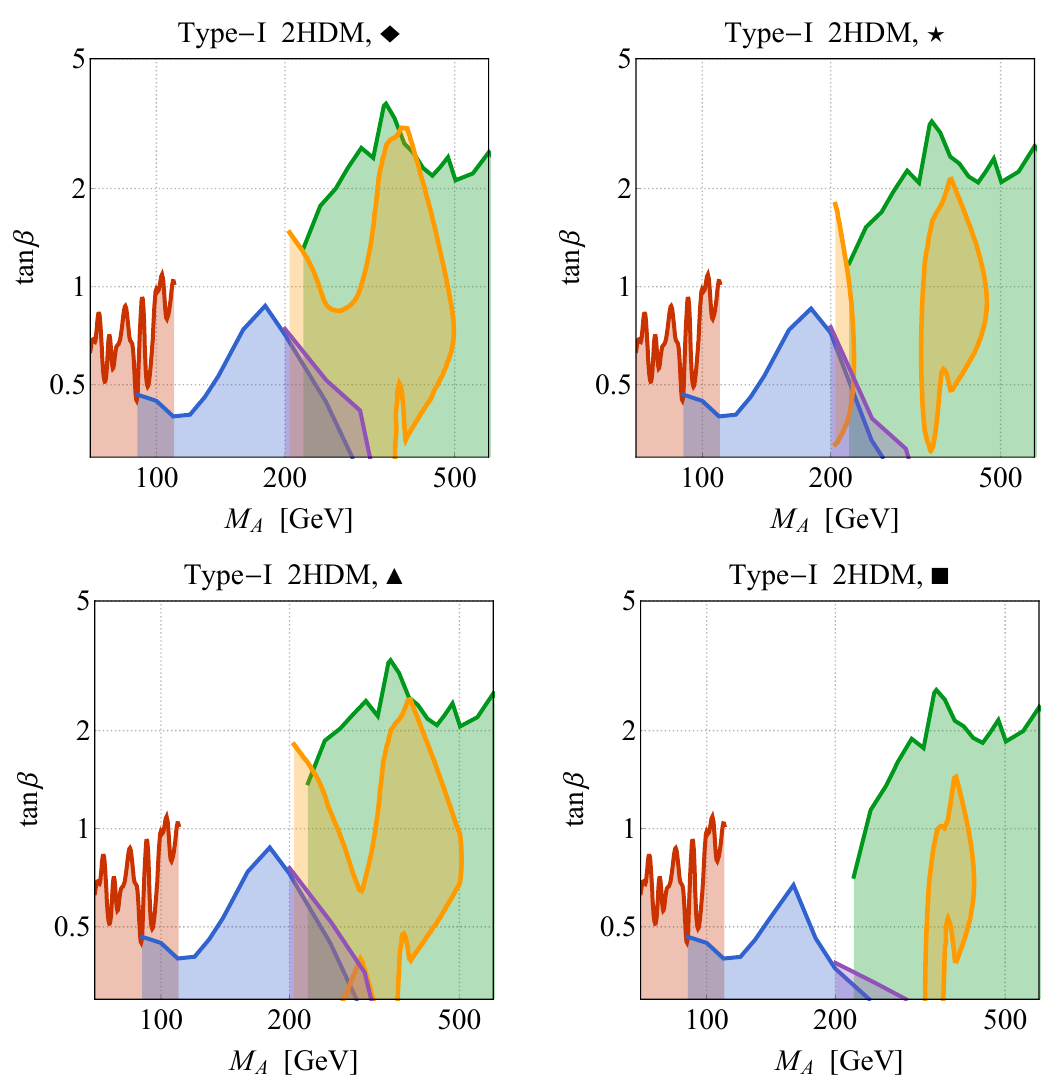
Figure 4 . Constraints on the M A {tan (cid:12) plane in the type-I 2HDM. The red contours indicate the bound imposed by the A ! (cid:13)(cid:13) search of CMS [13], while the blue and purple parameter regions correspond to the exclusions set by the A ! (cid:28) + (cid:28) (cid:0) search by CMS [31] and ATLAS [35], respectively. The green and yellow contours show furthermore the parameter sets that are disfavoured by the ATLAS analysis of A ! Zh [37] and the CMS search for A ! ZH [38]. The panels from upper left to lower right correspond to the benchmark scenarios (3.1), (3.2), (3.3) and (3.4), respectively. All shaded regions are excluded at 95%